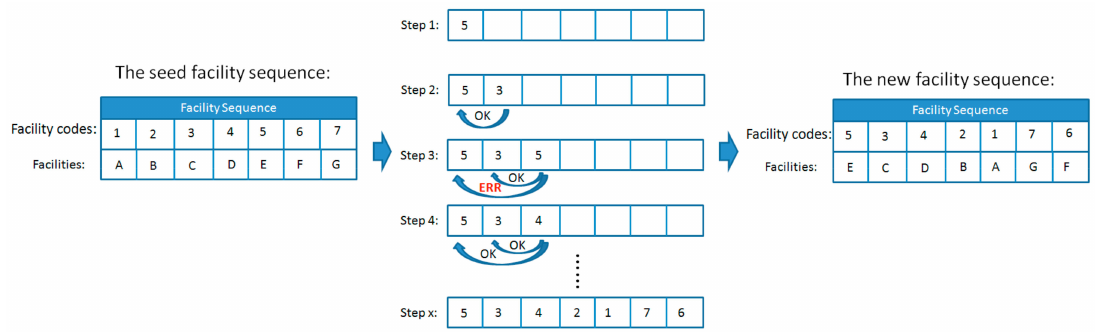
Figure 4. An example of the INI_FS1